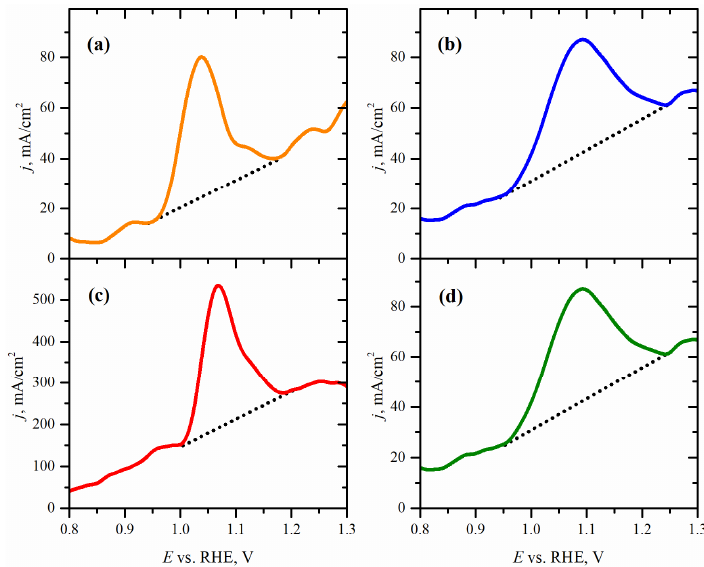
Figure 6. CO-stripping of ( a ) Pd/SiO 2 samples reduced in NaBH 4 ; in hydrazine: ( b ) Pd-NPs hydrazine and ( c ) Pd-NPs ammonia,hydrazine ; and ( d ) Pd-NPs PEG collected at 25 °C in 0.1 M HClO 4 solution.